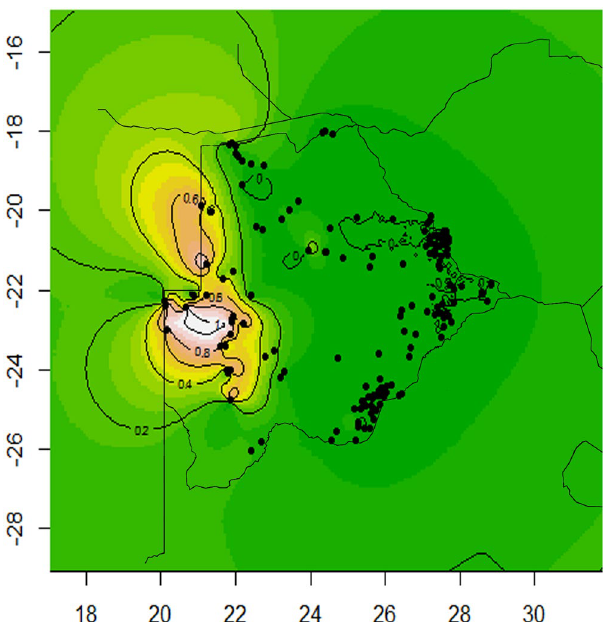
Figure 4. Geographical representation of the admixture coefficients through spatial kriging with low (cool colours) to high (hot colours) representing mean (TESS) admixture proportions. Individuals are classed from the non-admixture analysis in TESS with different colour and/or shapes representing different clusters. The green represents the Bantu and the pink represents the Khoisan. Map created using R 3.0.3 72 (http://www.R- project.org) package spatial 7.3.971 73 and maps 2.3.972 74